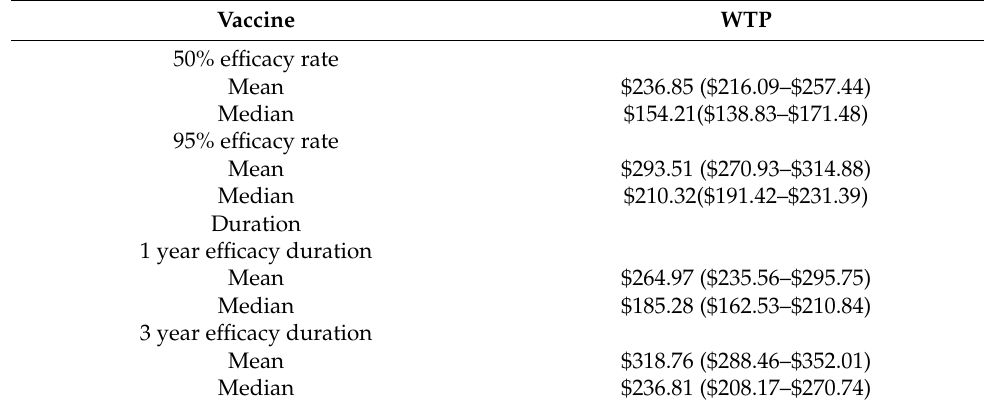
Table 4. Parametric estimates of mean and median WTP for a COVID-19